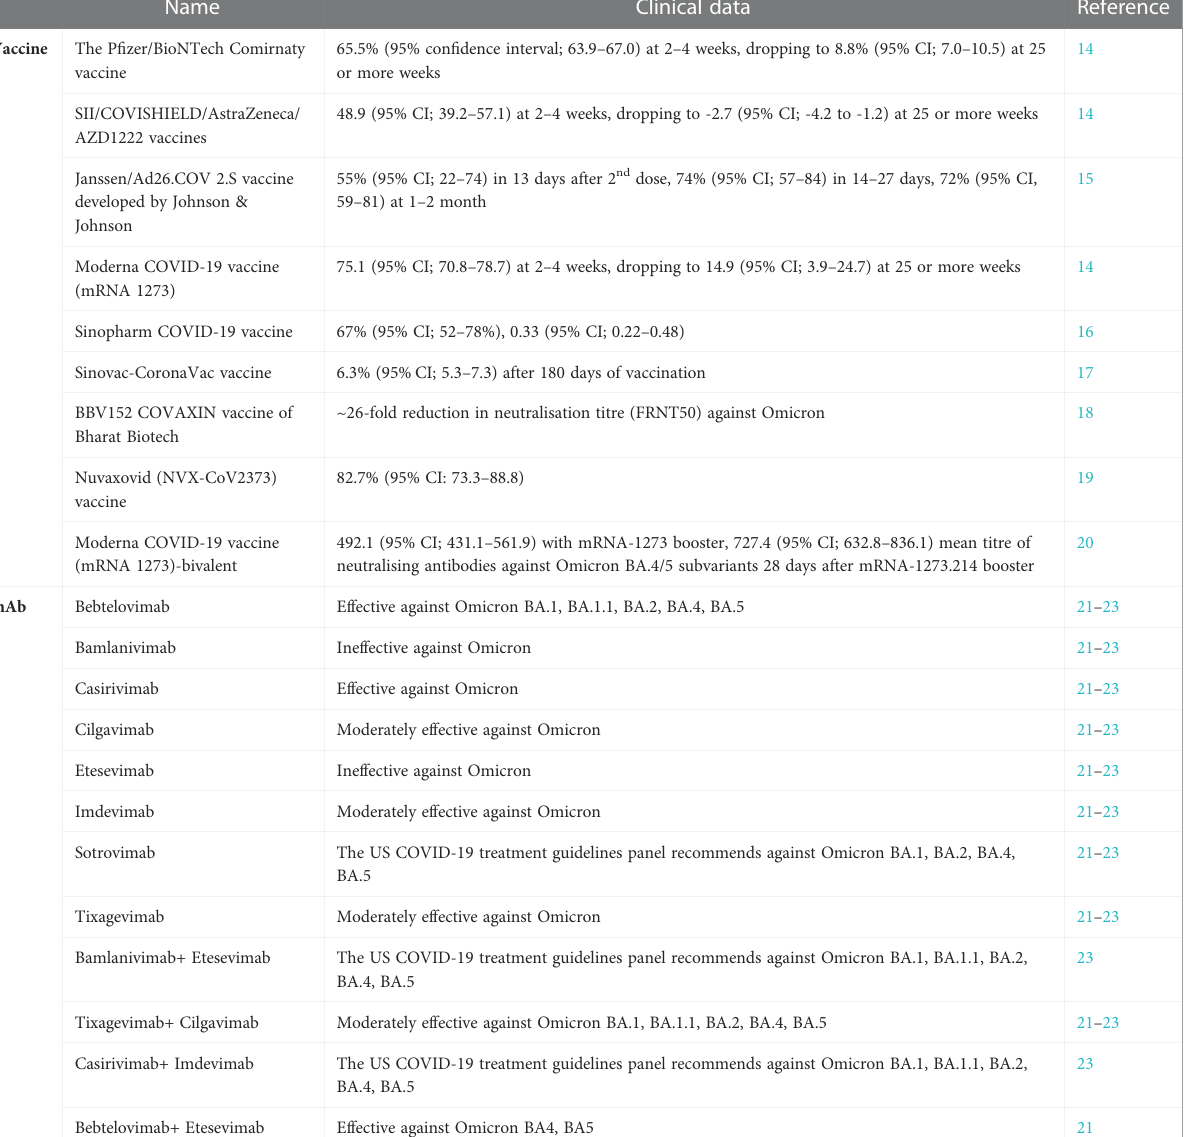
TABLE 1 Currently available vaccines and mAb therapies against SARS-CoV-2 variants.